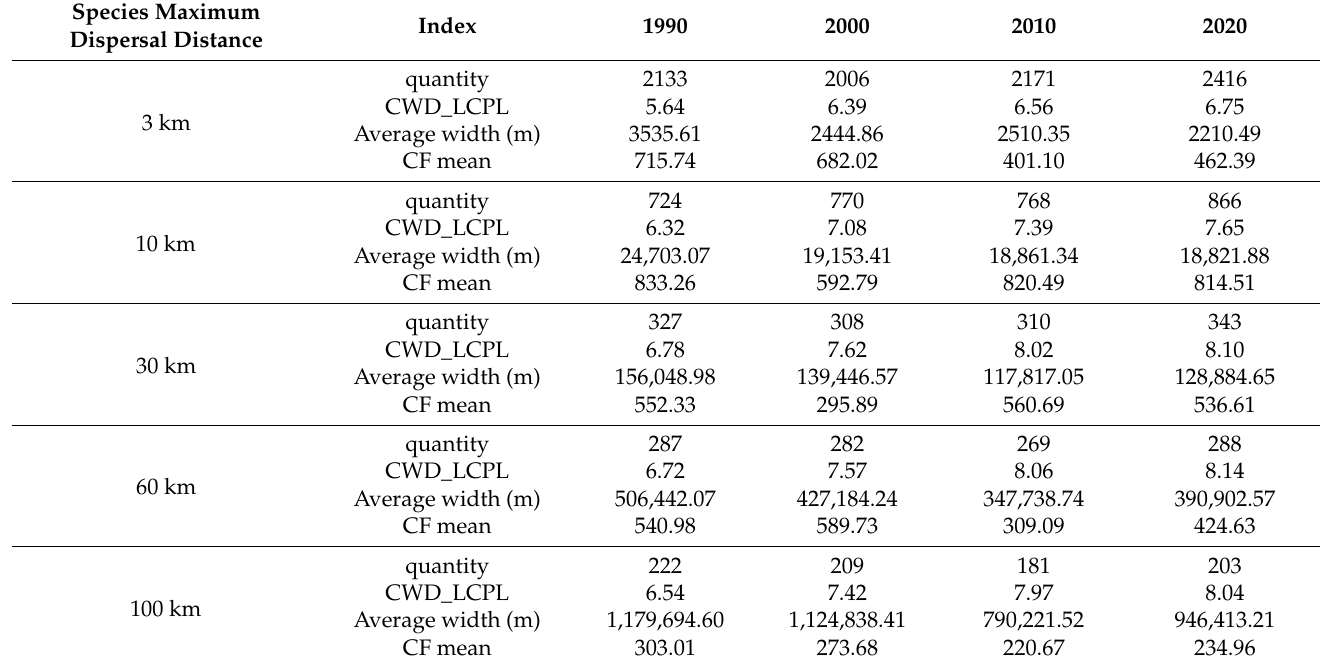
Table 5. Changes in the connectivity indicators of ecological corridors from 1990 to